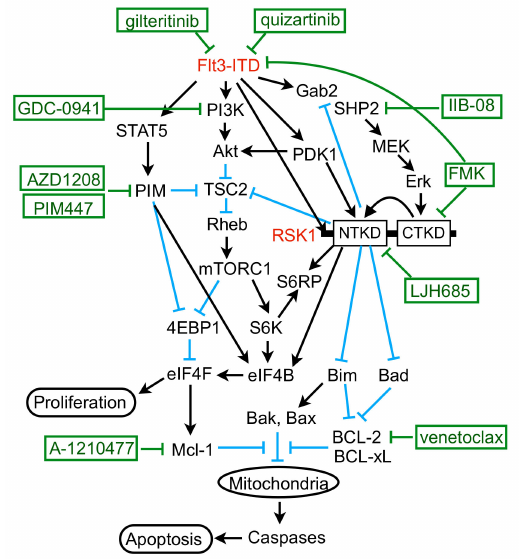
Figure 7. Schematic model for molecular mechanisms by which FLT3-ITD enhances proliferation and survival of AML cells through activation of